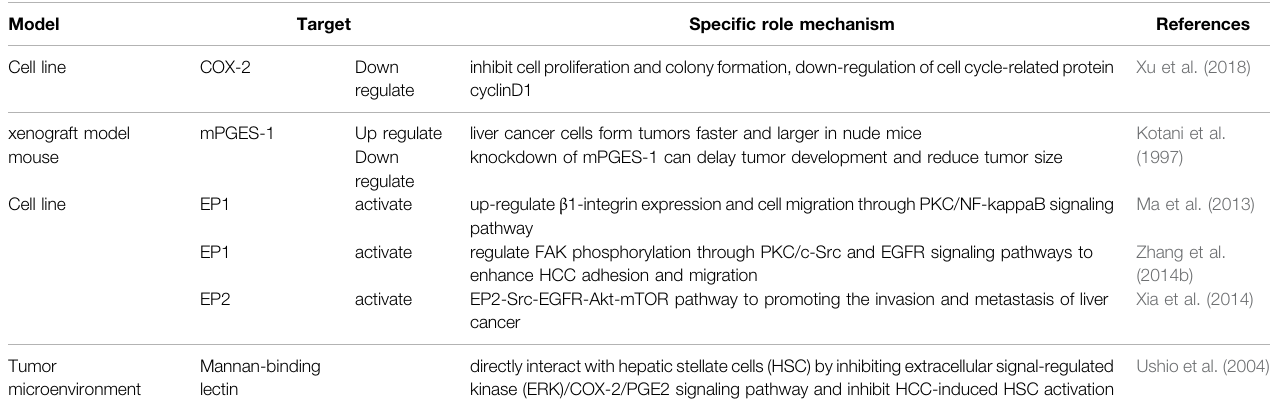
TABLE 2 | PGE2 enhance Hepatocellular Carcinoma metastasis and invasion through multiple recetports.